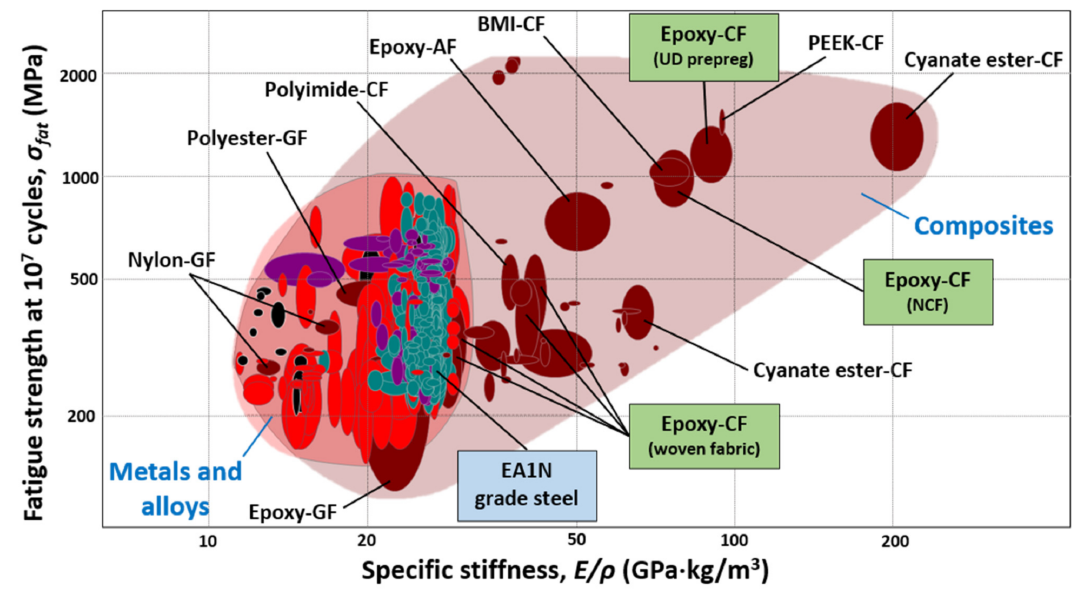
Figure 3. CES material selection chart for fatigue strength at 10 7 cycles against specific stiffness for “composites” and “ferrous and non-ferrous metals” with the applied attribute limits of fatigue and fracture toughness constraints. Each of the bubbles represents a material and the large, transparent bubbles represent the labelled bulk material